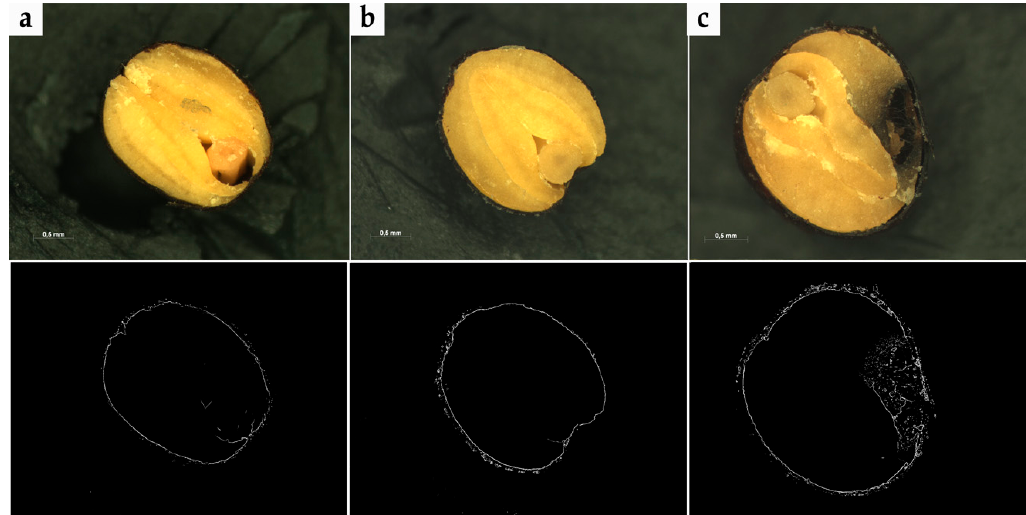
Figure 1. Examples of images that present rapeseed trials: ( a )—rapeseed free of contamination with initial moisture content of about 6%, ( b )—contaminated rape seeds stored in conditions characterized by 12% seed moisture content and at a temperature of 25 °C, ( c )—contaminated rapeseed stored in conditions characterized by 12% seed moisture content and at a temperature of 30 °C.